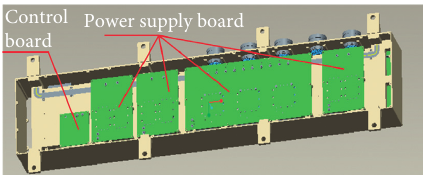
Figure 5: The schematic diagram of internal for array power